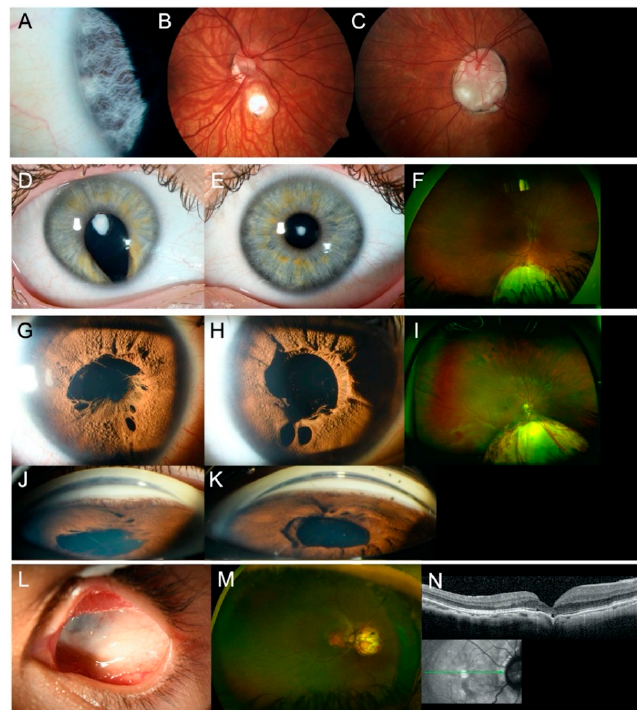
Figure 3. Ocular findings in affected individuals of families 2–4 and 7. ( A – C ) Slit lamp and fundus photographs of index patient 2[II:1] showing ( A ) posterior embryotoxon and ( B ) small chorioretinal coloboma in the right eye and ( C ) optic disc coloboma in the left eye. ( D – F ) Slit lamp photographs and Optomap™ image of index patient 3[II:1] showing ( D – E ) anterior polar cataract in both eyes and ( D,F ) iris and chorioretinal coloboma in the right eye. ( G – K ) Slit lamp photographs and Optomap™ image of index patient 4[II:2] showing Axenfeld-Rieger anomaly in both eyes, with ( G – H ) iris hypoplasia, polycoria, persistent pupillary membrane, ( I ) chorioretinal coloboma in the right eye (left eye not shown), and ( J – K ) goniodysgenesis in both eyes. ( L – N ) Slit lamp photograph, Optomap™ image, and spectral domain optical coherence tomography image of index patient 7[II:1] showing ( L ) severe microphthalmia in the left eye and ( M – N ) juxtapapillary chorioretinal coloboma in the right eye.